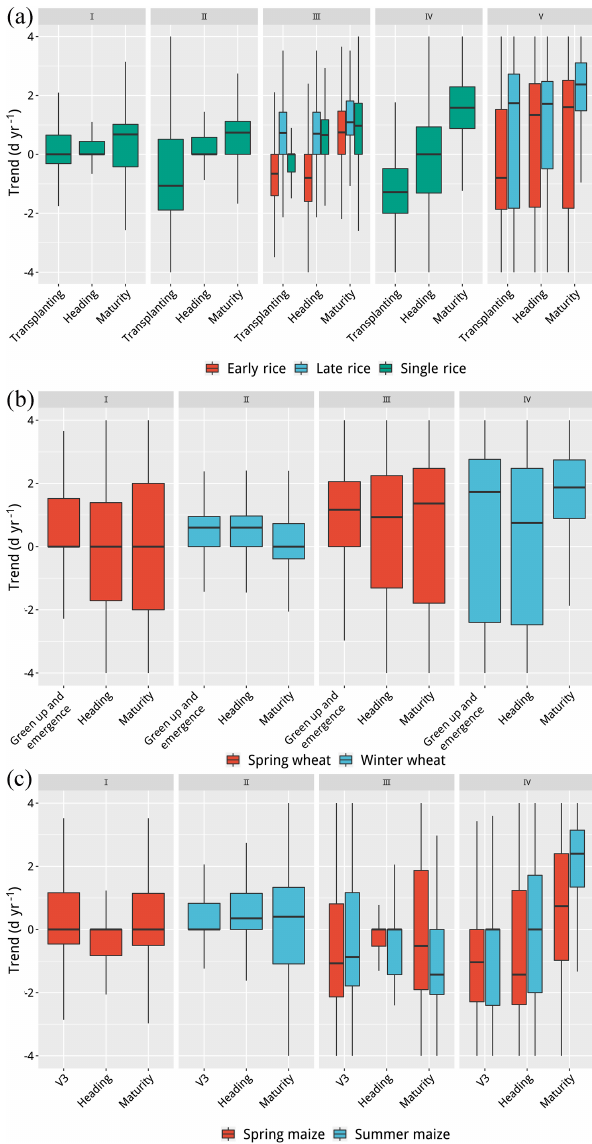
Figure 9. The trends of three key phenological dates during 2000– 2015 by crop and subregions for rice (a) , wheat (b) and maize (c) .